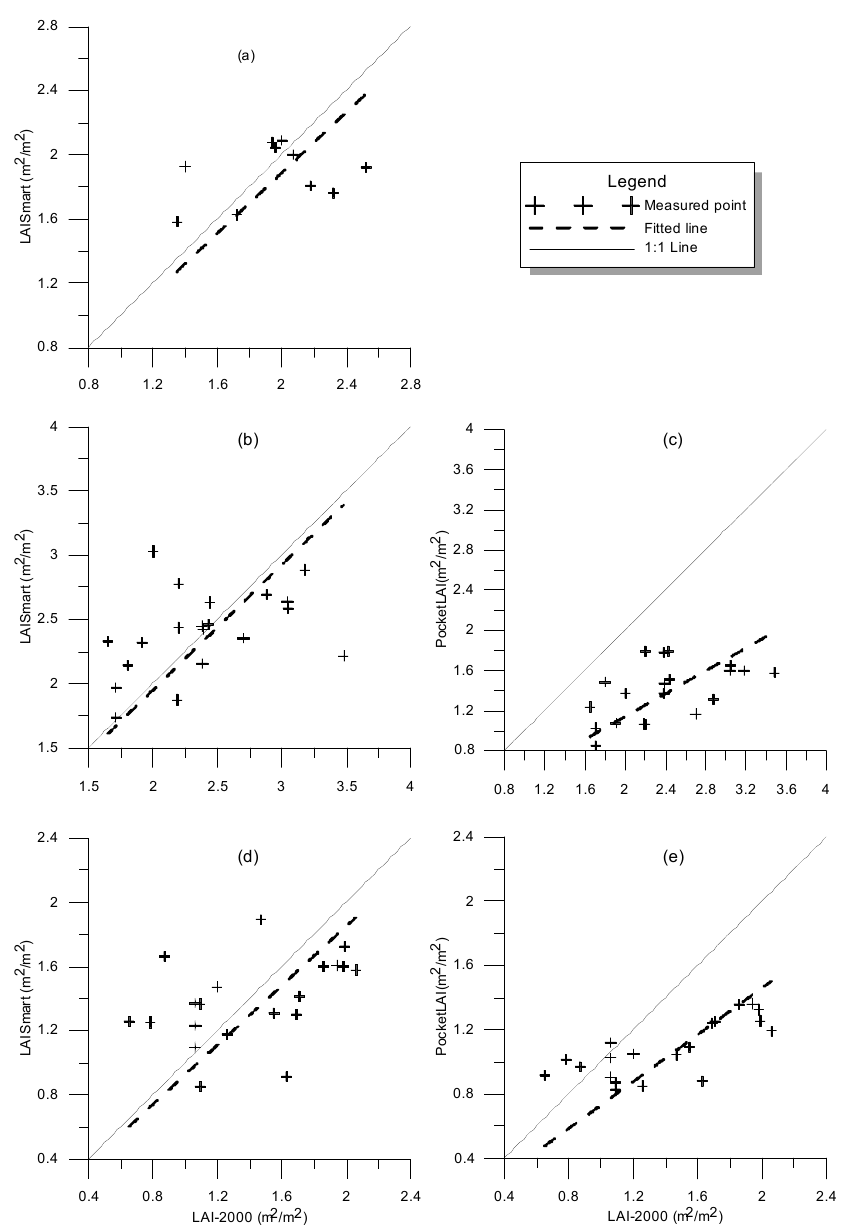
Figure 2. Scatter plot between LAI values of LAI-2000 and those of two smartphone methods (left column for LAISmart and right column for PocketLAI) on three dates (subplot ( a ) for 26 May, ( b ) and ( c ) for 25 July and ( d , e ) for 22 September). Table 3. Statistics parameters of the measured and reference LAI values.